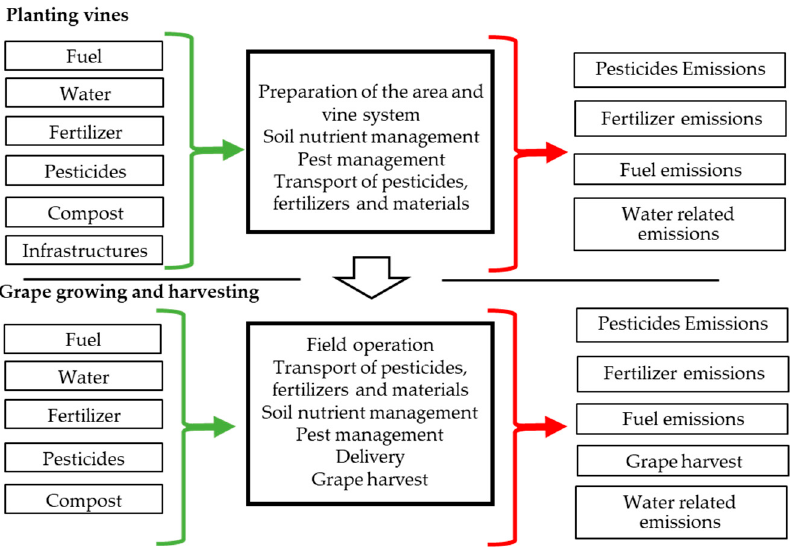
Figure 2. Systems boundaries of the research.